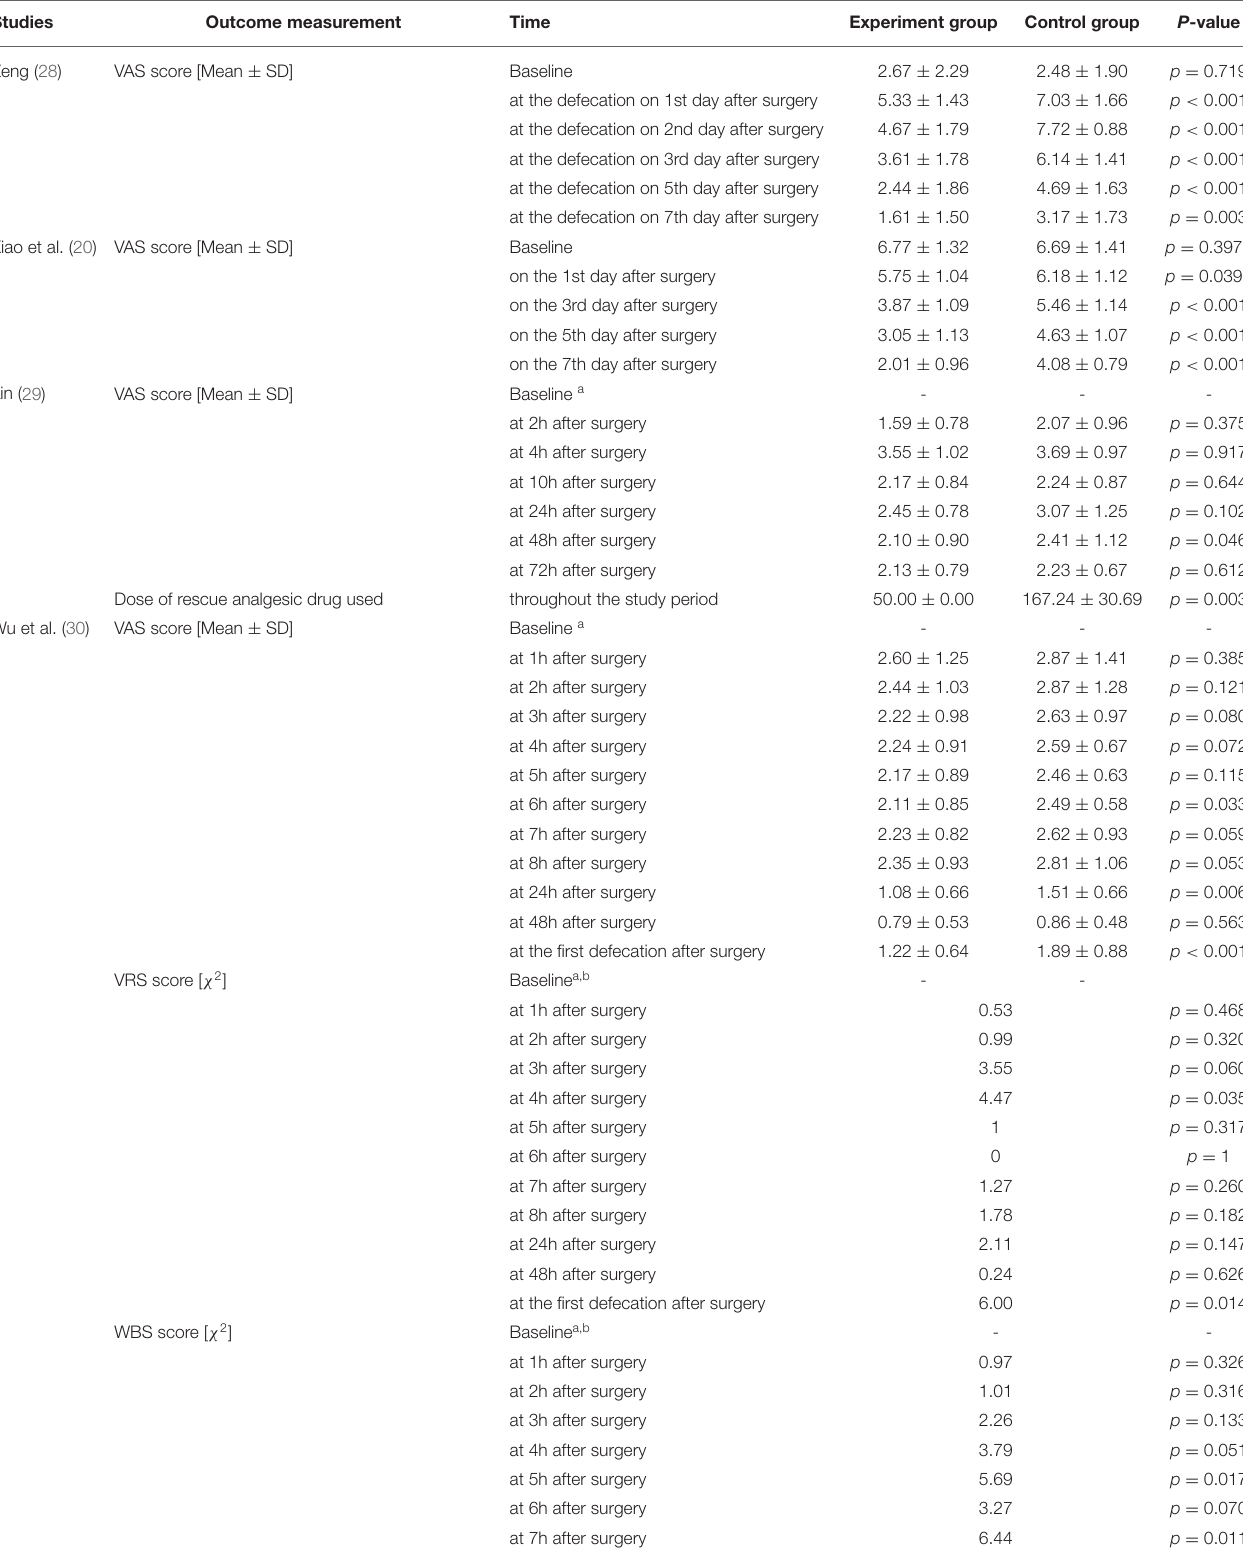
TABLE 2 | Outcomes of included